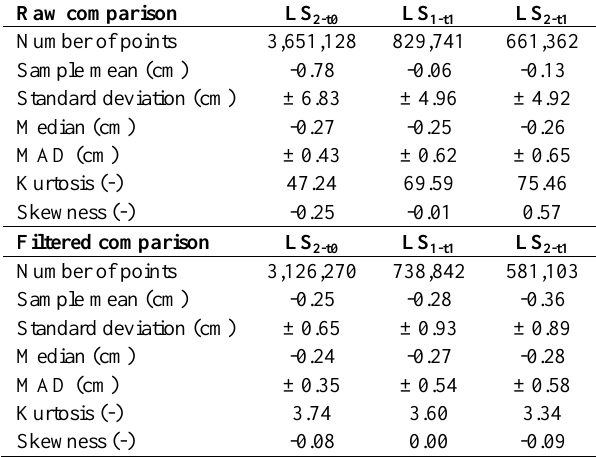
Table 2. Statistical results of the raw and post-processed MMS data analyses.